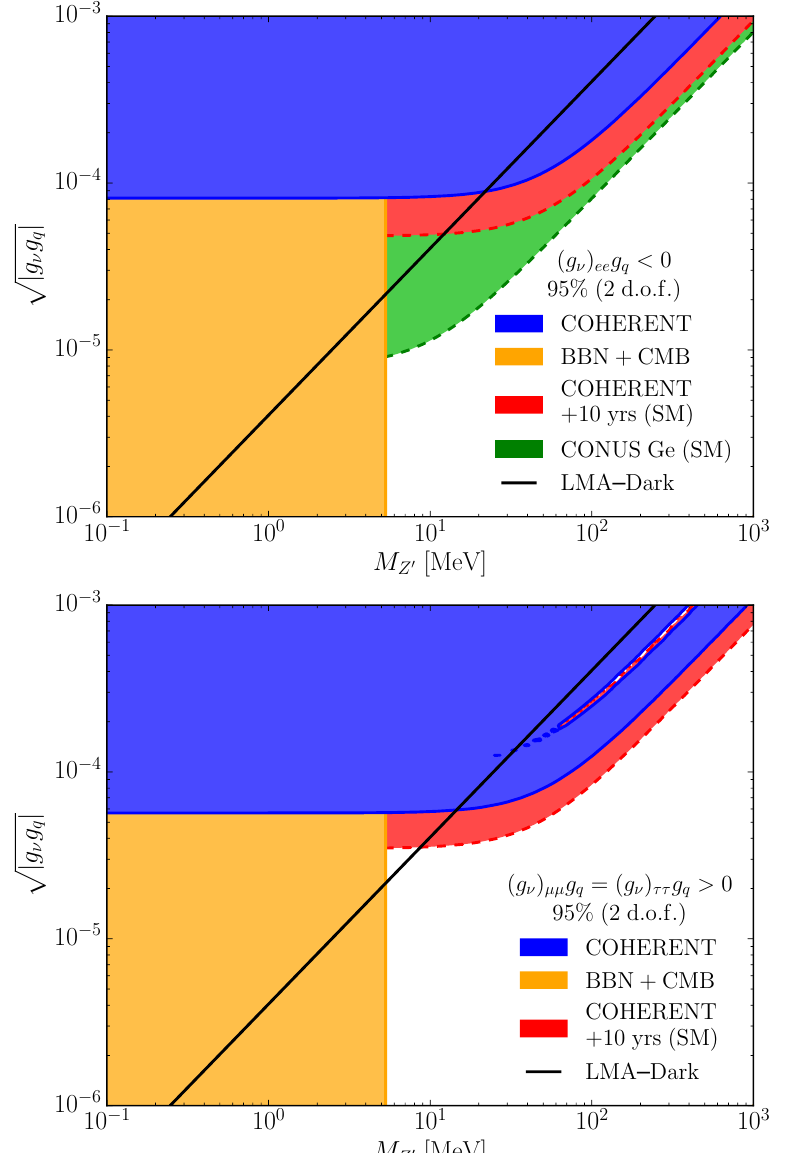
Figure 7 . Bounds on the product of couplings to neutrino and quark versus the mass of mediator. In the top (bottom) panel, g (cid:23) indicates ee ( (cid:22)(cid:22) ) component. The blue and red regions show the 95% C.L. with 2 d.o.f. constraints on NSI respectively from the present COHERENT data and the forecast for 10 more years of COHERENT running with CsI assuming no NSI. The sliver on the bottom panel is a result of the degeneracy in eq. (4.6). The constraint from BBN and the CMB is shown in orange [22]. The CONUS (see section 5.2) constraint in green conservatively takes the Germanium detector and assumes that they will measure the SM. CONUS cannot constrain the (cid:22)(cid:22) or (cid:28)(cid:28) terms. The black line in the top (bottom) panel correspond to the LMA-Dark solution with x = 0 (with x = 2). Note that g (cid:23) g q is taken to be negative (positive) for the top (bottom) panel to give the LMA-Dark solution at x = 0 ( x = 2). Solid lines are current bounds, dashed lines are future